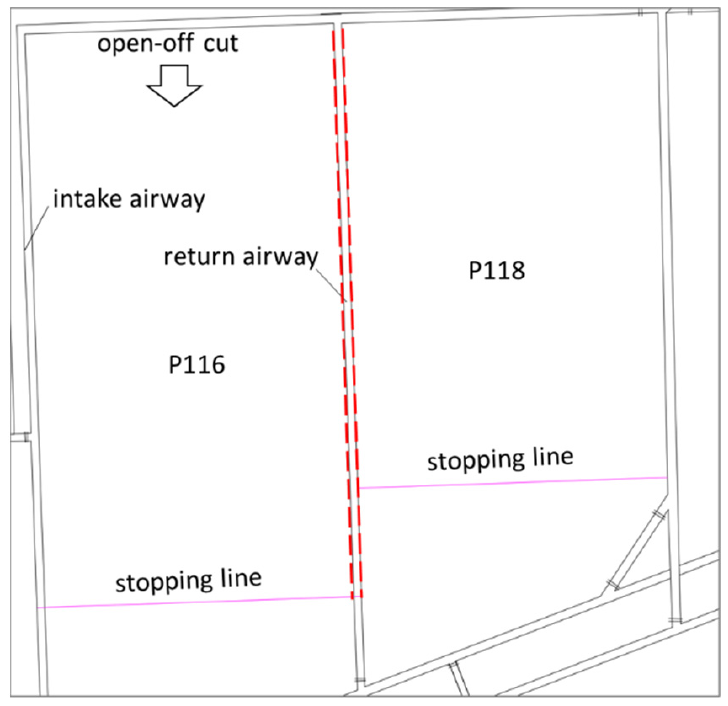
Figure 11. Schematic layout of working face. Table 1. Regional lithological situation.